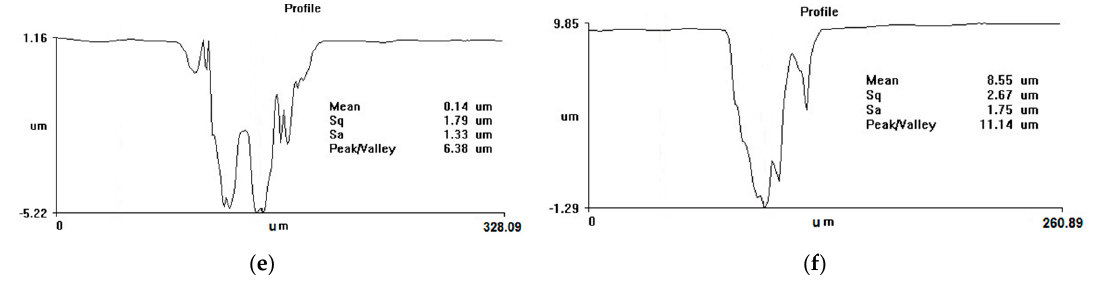
Figure 3. Profiles of holes drilled in aluminum in water at two different pulse repetition rates for various numbers of pulses. ( a ) 500 kHz, 100 pulses; ( b ) 10 kHz, 100 pulses; ( c ) 500 kHz, 1000 pulses; ( d ) 10 kHz, 1000 pulses; ( e ) 500 kHz, 10,000 pulses; ( f ) 10 kHz, 10,000 pulses.